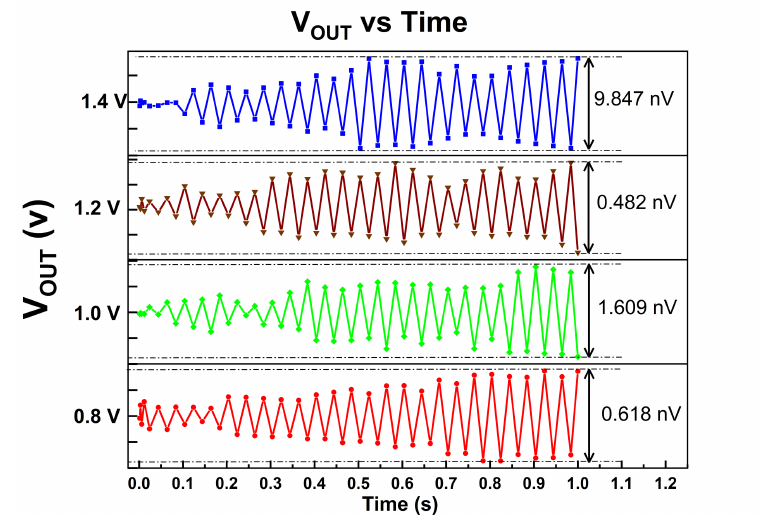
Figure 10. Simulated output voltage ripple of proposed